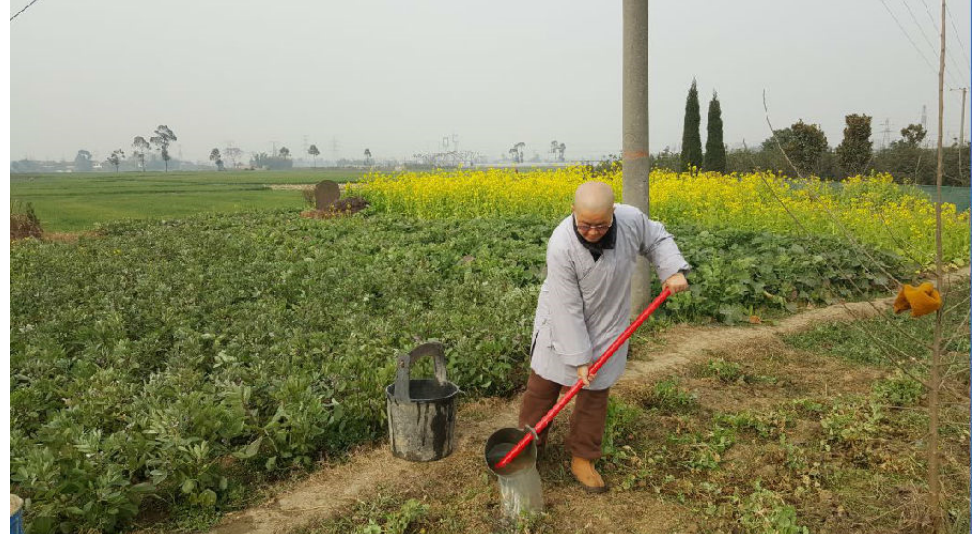
Figure 4. Bhi ṣ uni Xuzhi was working in the field as a farming Chan ( nongchan 農禪 ). (Taken from Figure 4. Bhis.uni Xuzhi was working in the field as a farming Chan ( nongchan 農 禪 ). (Taken from the the Mahasati Dynamic Meditation Center website). Mahasati Dynamic Meditation Center